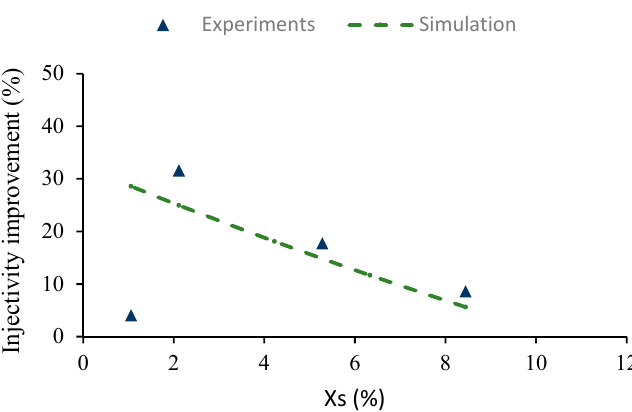
Figure 8. Effect of diluent brine Salinity on CO 2 injectivity after treating the impaired core with CO 2 Low Salinity Alternating Gas (CO 2 -LSWAG).